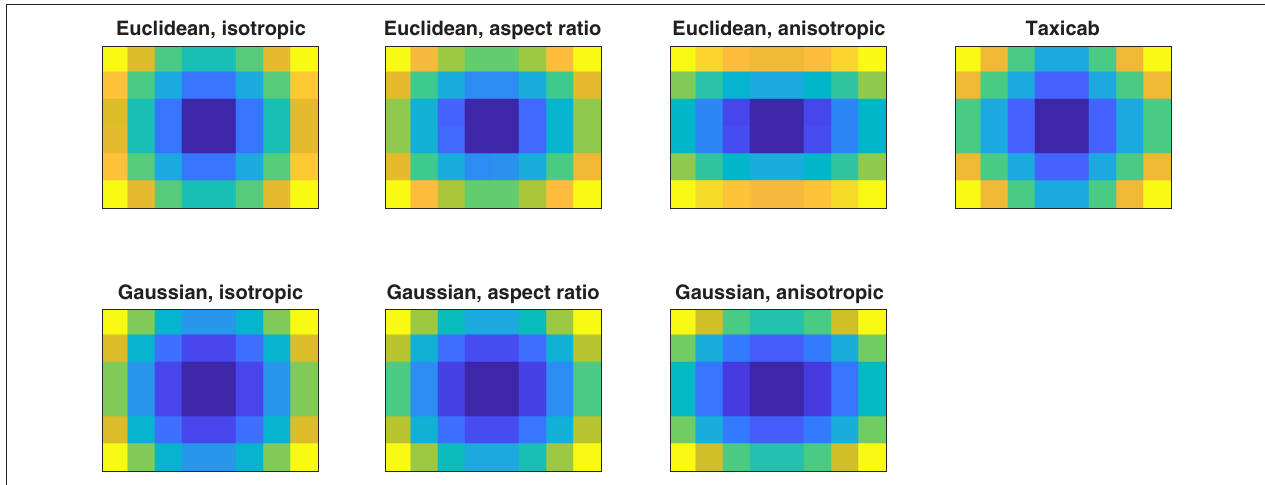
FIGURE 2 | Visualization of the central-bias variables calculated by the GridFix toolbox. Color coding indicates normalized distance of corresponding cell centers to image center (brighter is more peripheral; dark blue: smallest distance, normalized to 0; yellow: largest distance, normalized to